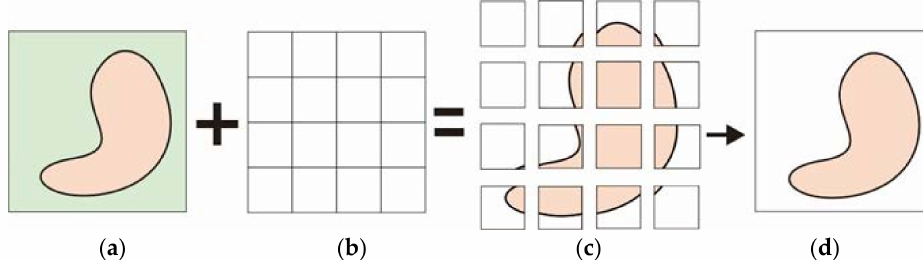
Figure 1. Basic principle of filling an open hole using the Han method; ( a ) original closed hole; ( b ) partitioning grid; ( c ) open holes generated by partitioning; ( d ) open hole